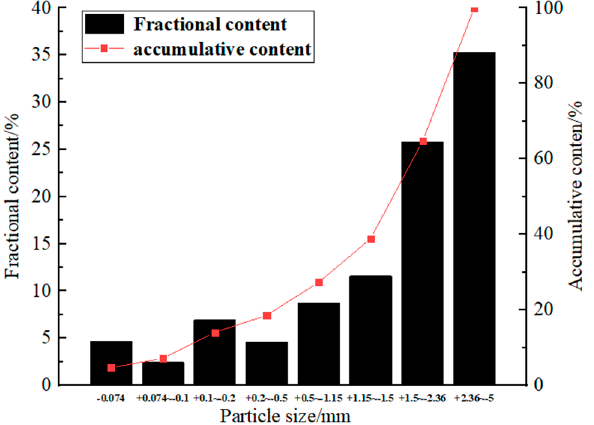
Figure 2. Particle size composition of waste rock filled with aggregate.